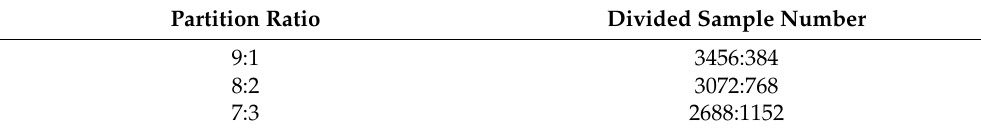
Table 6. Data partition ratio.